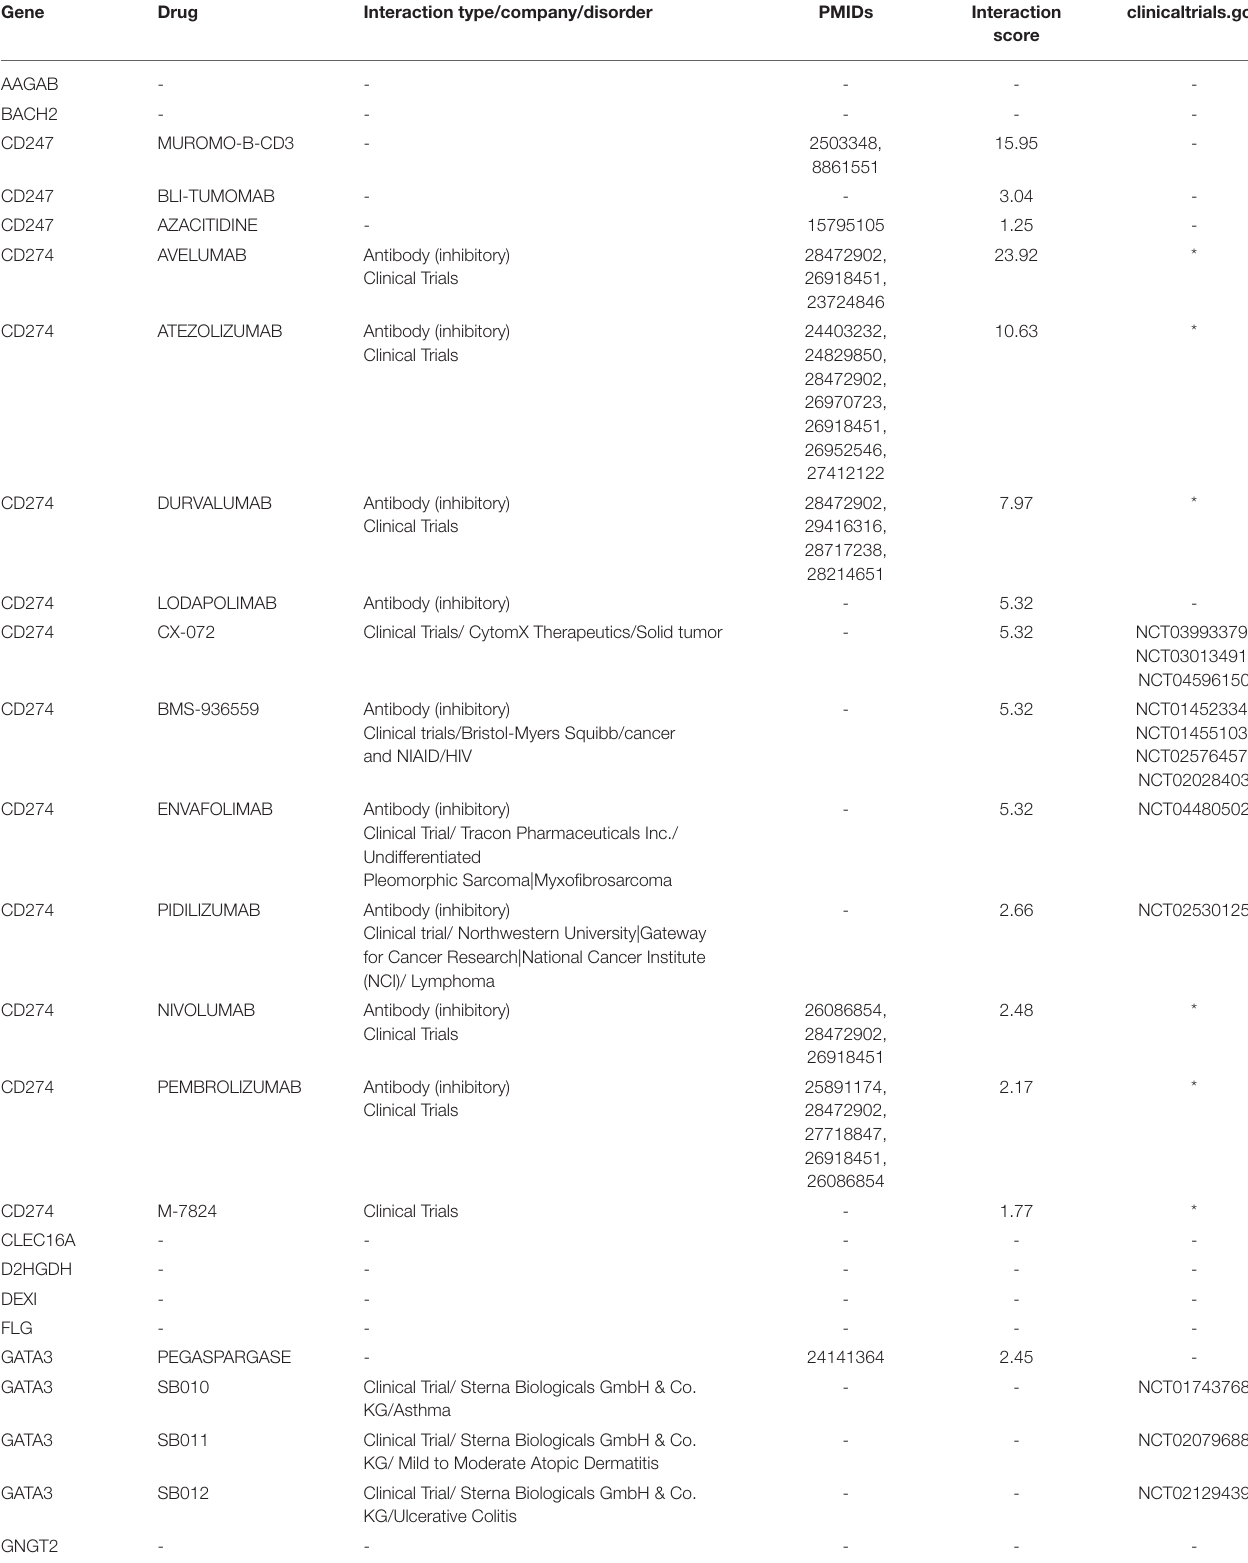
TABLE 7 | Known drug interactions and molecules currently in clinical trials of 37 candidate causal genes and five predicted genes. Gene Interaction type/company/disorder PMIDs Interaction